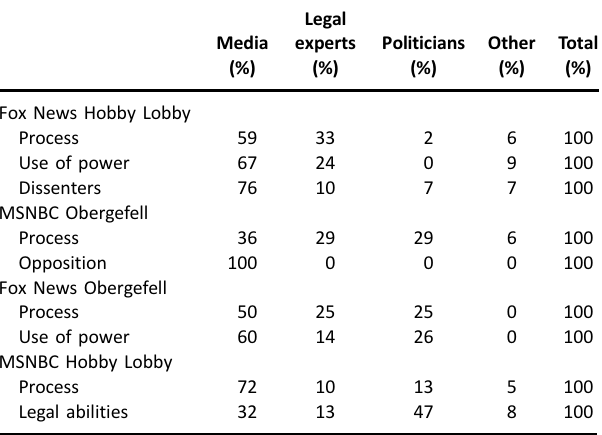
Table 1. Frame-specific distribution